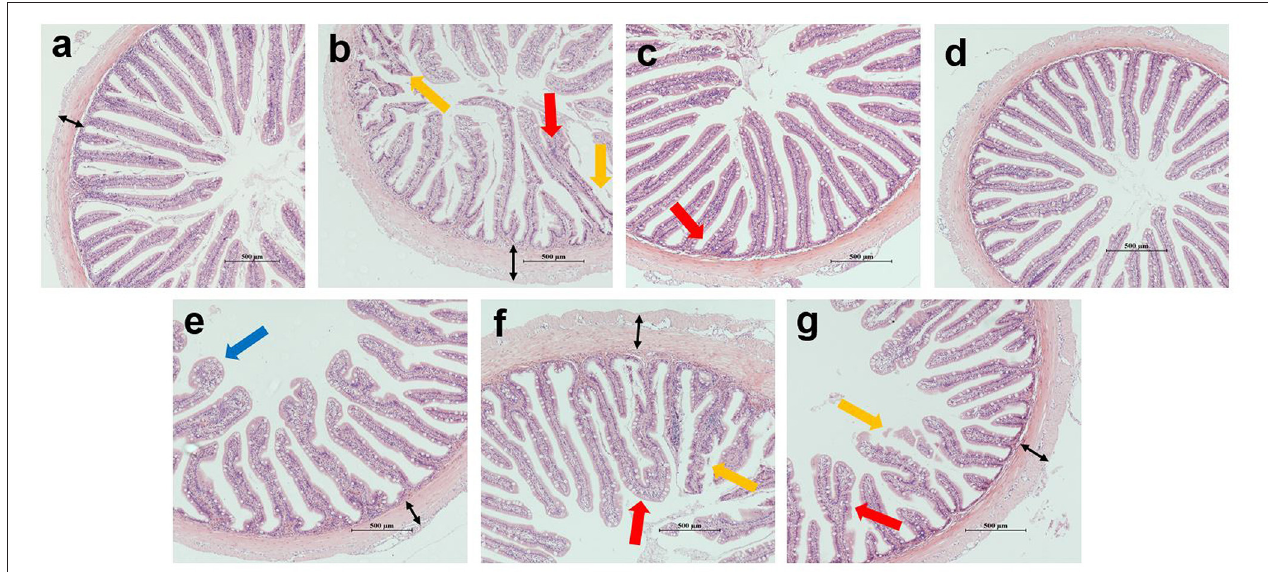
FIGURE 2 | Intestinal morphology of grouper (magnification × 100). (a–g) correspond to FM, COS0, COS0.2, COS0.4, COS0.6, COS0.8 and COS1 groups, respectively. Red arrow: plica adhesion; yellow arrow: plica breakage; blue arrow: vacuolation of epithelial cells; black arrow: thickness of lamina propria. Scale size is 500 µ m.